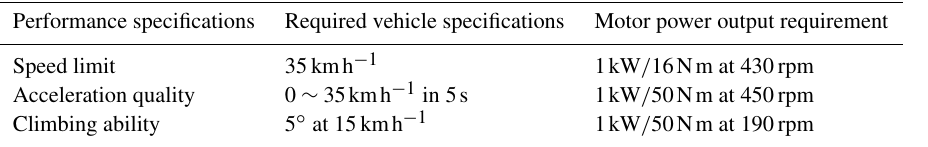
Table 4. Expected performance.